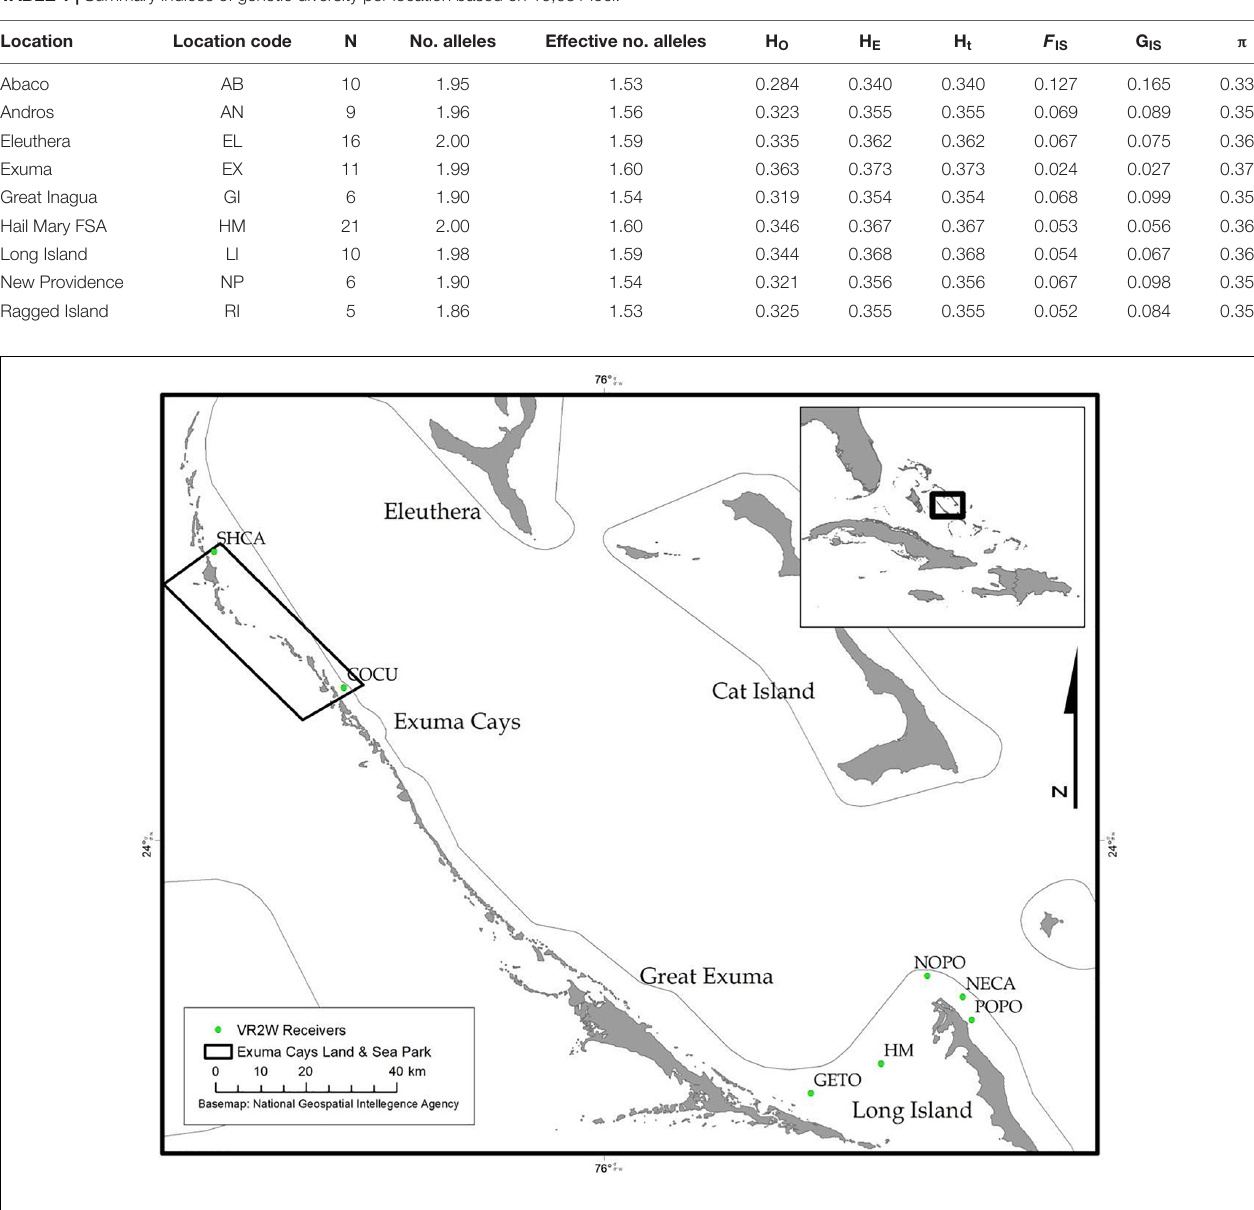
FIGURE 2 | Map of acoustic receivers (VR2Ws) [denoted by green circles] deployed around the Exumas and Long Island, Bahamas. Receiver codes correspond to: SCHA, Shroud Cay; COCU, Conch Cut; GETO, Georgetown; HM, Hail Mary; NOPO, North Point; NECA, Newton’s Cay; POPO, Poseidon’s Point. SHCA and COCU are located within the boundaries no-take Exuma Cays Land and Sea Park (rectangular shape outlined in black). The inset map shows the Exuma Sound study area (black box) in relation to the rest of The Bahamas, Florida and the